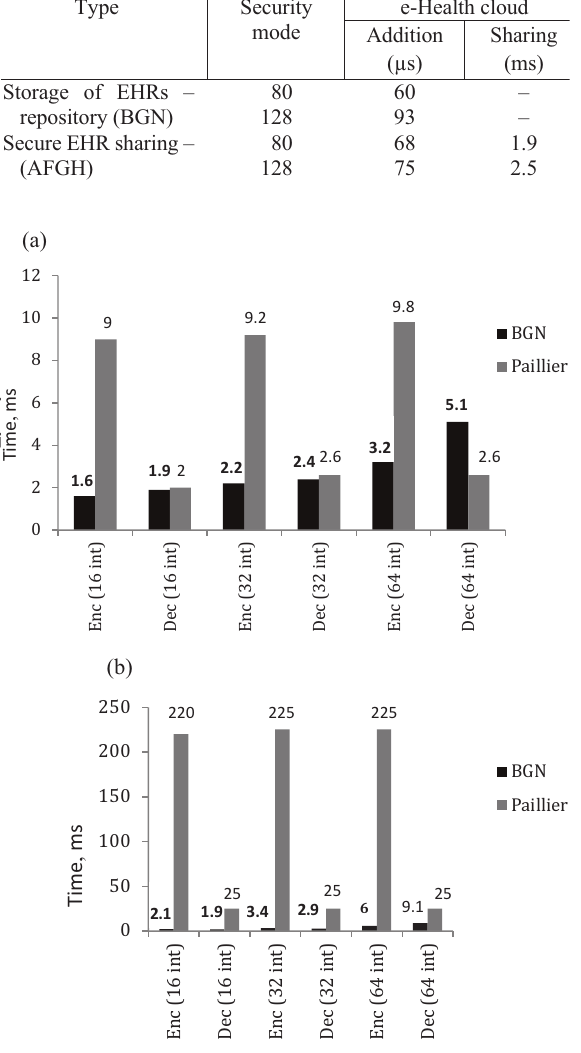
Fig. 5. (a) Execution time comparison – BGN vs. Paillier – 80 bit; (b) Execution time comparison – BGN vs. Paillier – 128